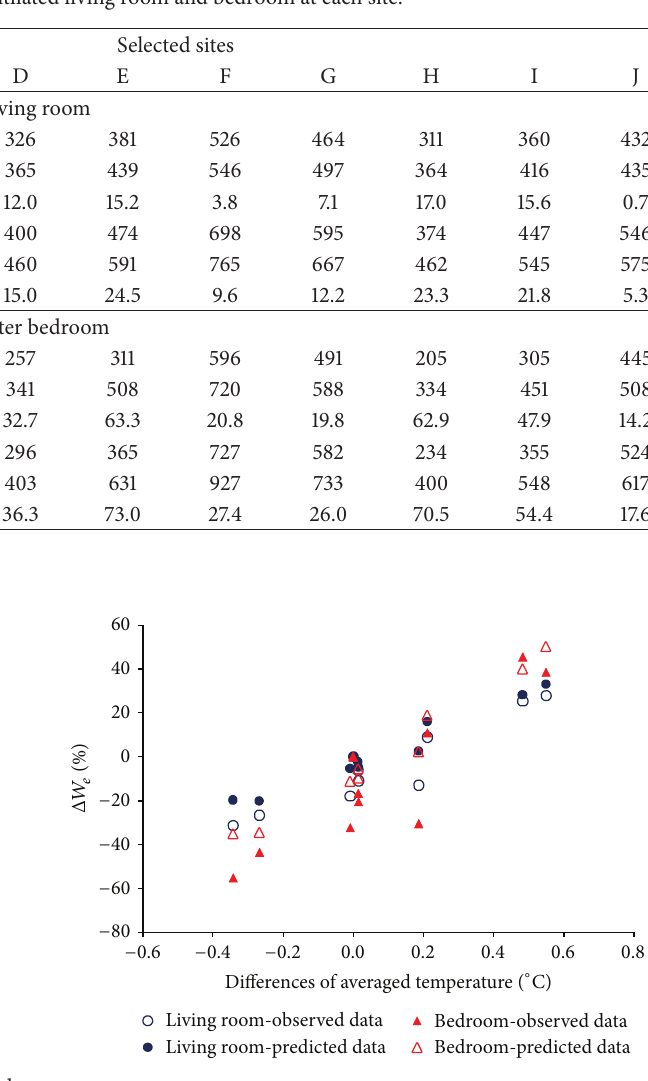
Figure 10: The percentage of Δ𝑊 𝑒 versus difference of averaged temperature during the research